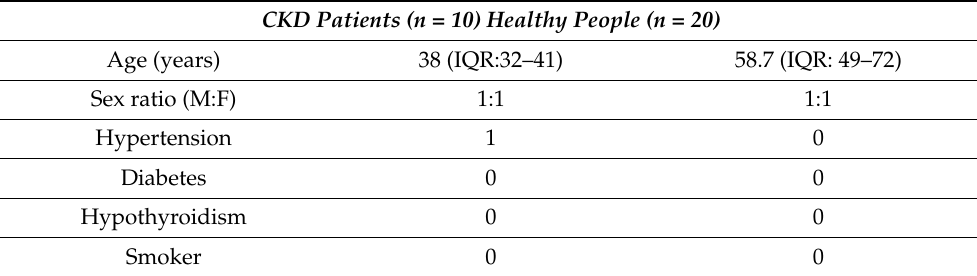
Table 2. Demographics and comorbidities in CKD and control